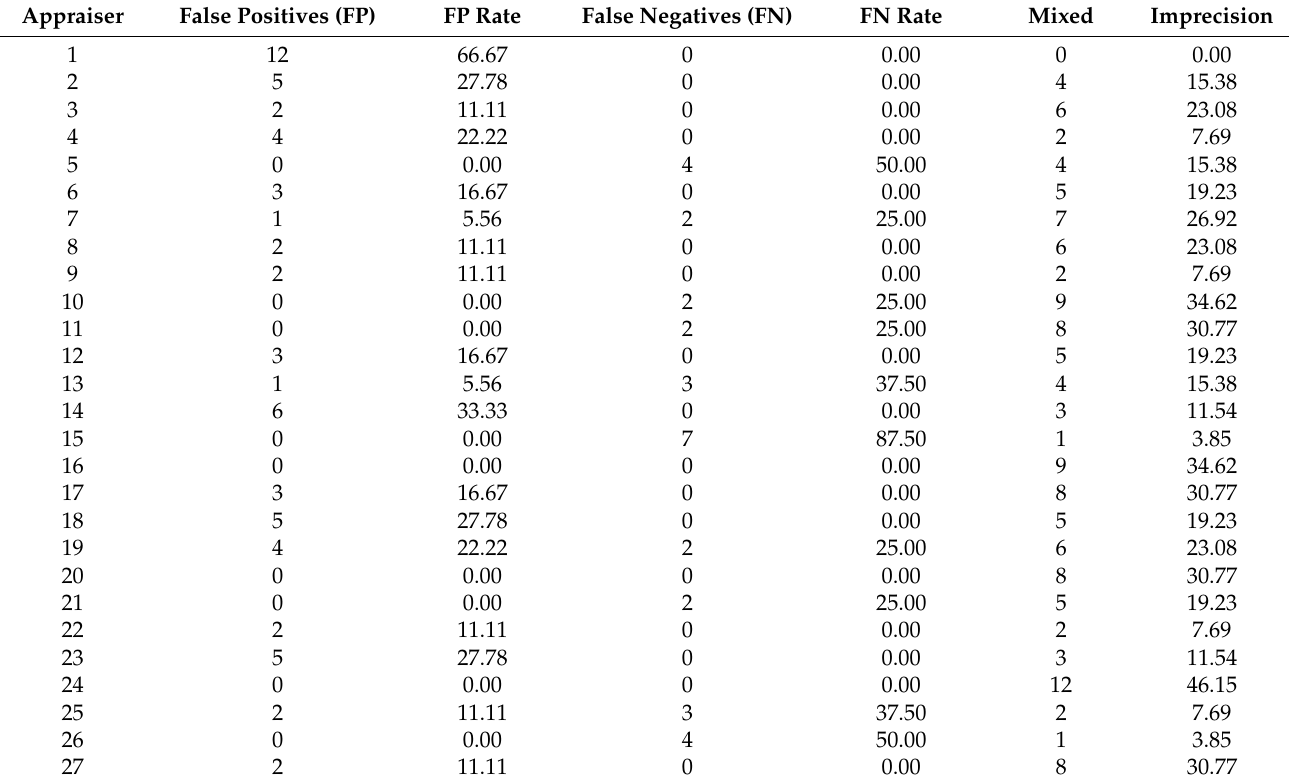
Table A3. Summary of Inspection Errors (Disagreement with Ground